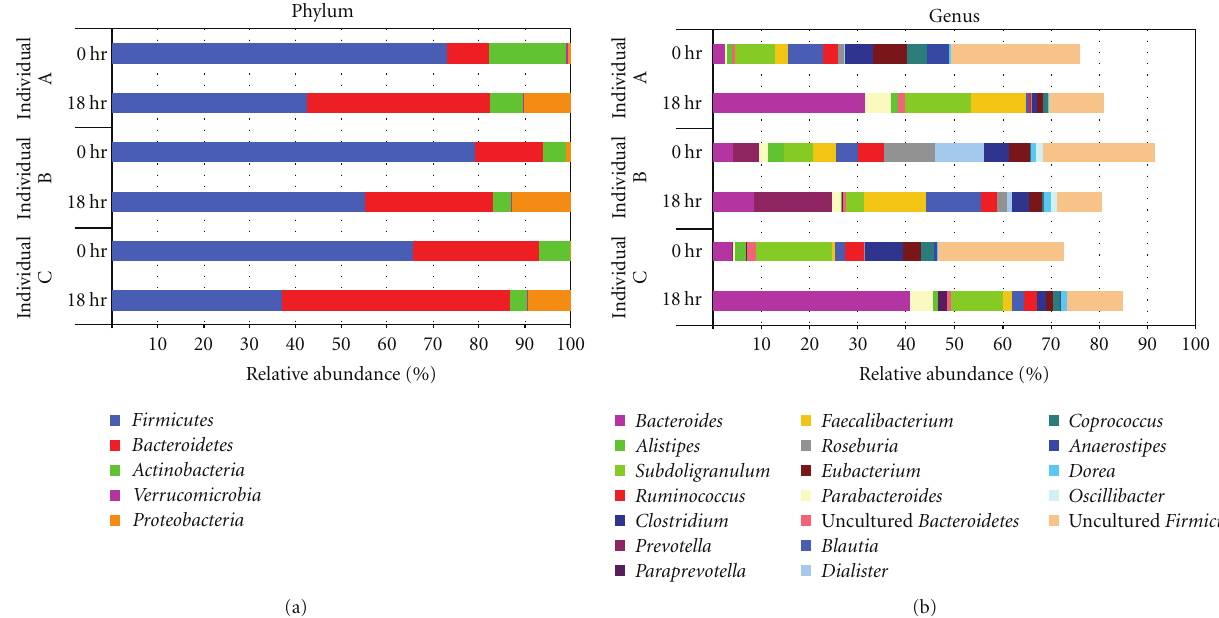
Figure 3: The relative abundance of dominant phyla and genera identified from pyrosequencing data. The communities of each person were compared at 0 hour and after 18 hours. The dominant phylotypes were determined by the abundance greater than 1% of total analyzed